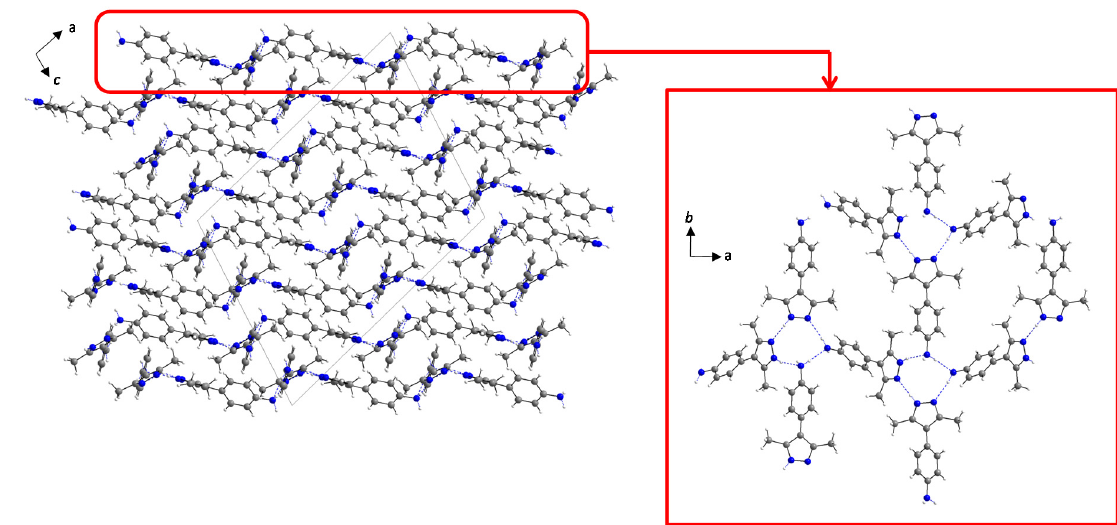
Figure 6. Packing of P3 in the ac plane and supramolecular 2D network formed by hydrogen bonds between four molecules formed in the ab plane. Table 7. Intermolecular H-bond data for P3.